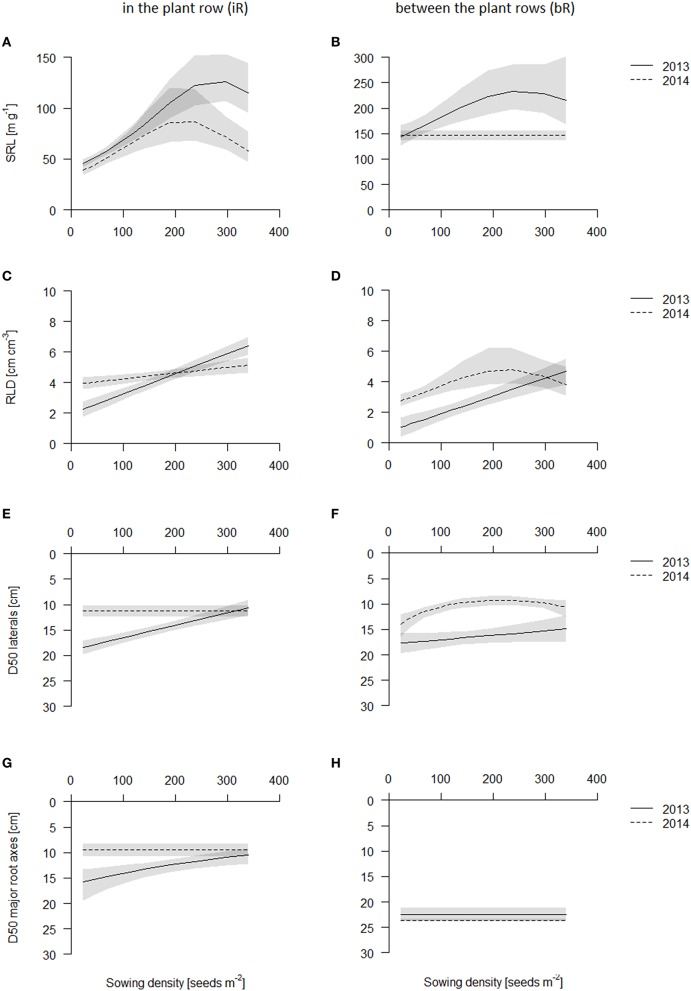
Belowground traits of the coring in 2013 (solid line) and 2014 (dashed line) in the plant row (iR, left) and between the plant rows (bR, right). Data are presented as best fits with 95% confidence interval (gray). For equations, R2 and p-values see Table S3. SRL in the topsoil iR (A) and bR (B); RLD in the topsoil iR (C) and bR (D); D50 values of laterals iR (E) and bR (F); D50 values of major root axes iR (G) and bR (H).